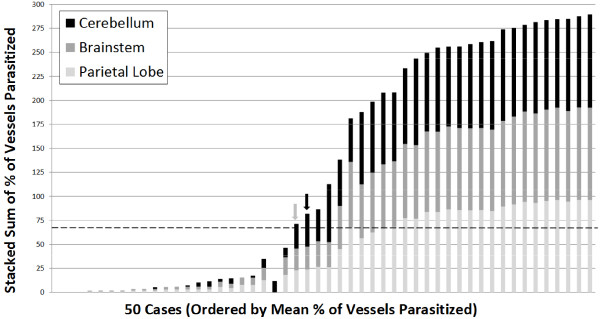
The distribution across 50 sequential cases of vessel sequestration (as measured by % of vessels parasitized) across three sites within the brain are shown as stacked bars (maximum = 300 represented 100% of vessels parasitized × 3 sites). Cases are ordered by mean % of vessels parasitized. The dotted horizontal line represents the overall cut-off for “cerebral malaria” (23.3% × 3 sites = 69.9) and demonstrates two outliers as follows: (grey arrow) a case of coma of other cause with anaemia and no evidence of retinopathy whose parietal lobe measures was <23.3% but cerebellum was >23.3%; and (black arrow) a case of severe malaria anaemia whose parietal lobe measure was >23.3% but the child did not meet the clinical case definition of cerebral malaria.